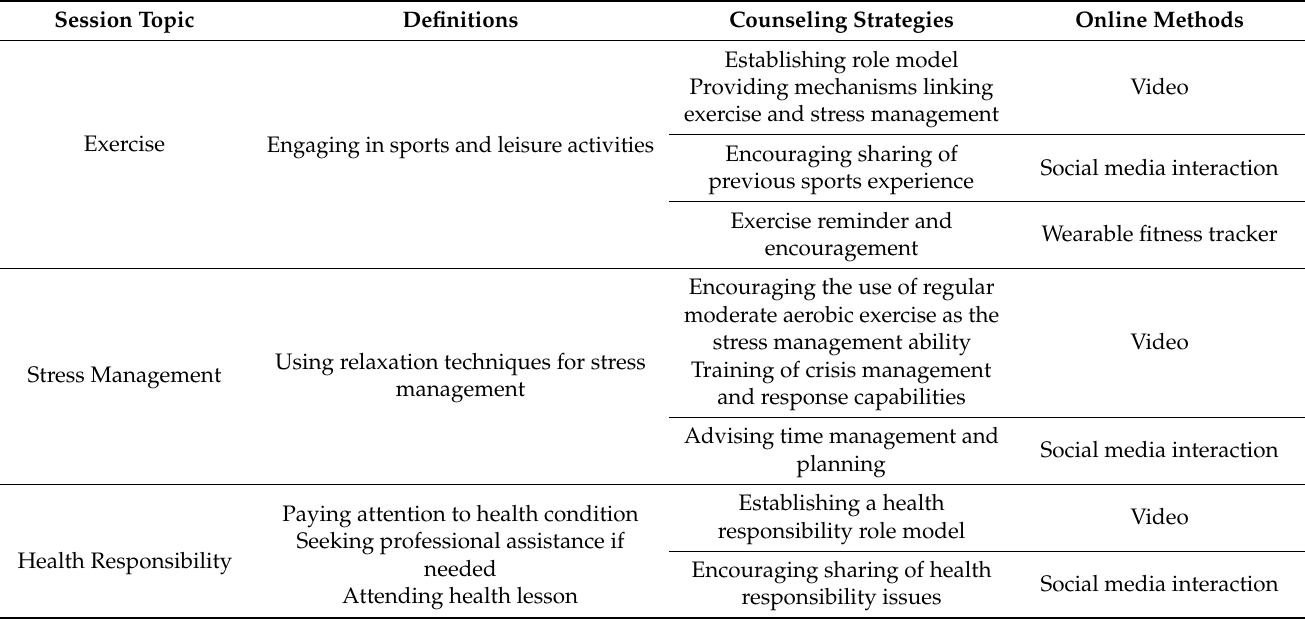
Table 1. The detailed procedures of Online Health-Promotion